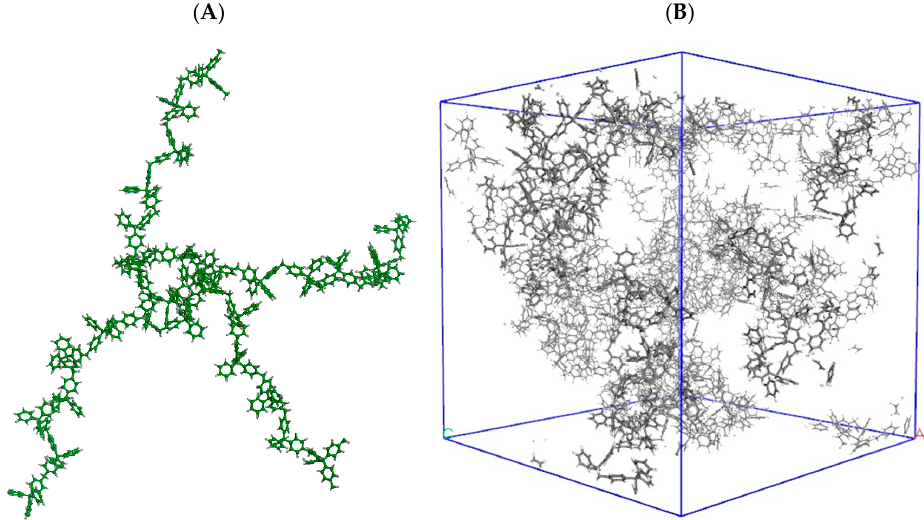
Figure 2. The building unit ( A ) and a possible 3D structure ( B ) of the model proposed for UPO materials in reference [60]. The building units are polymerized and assembled in disordered solids ( B ) with given macroscopic density.